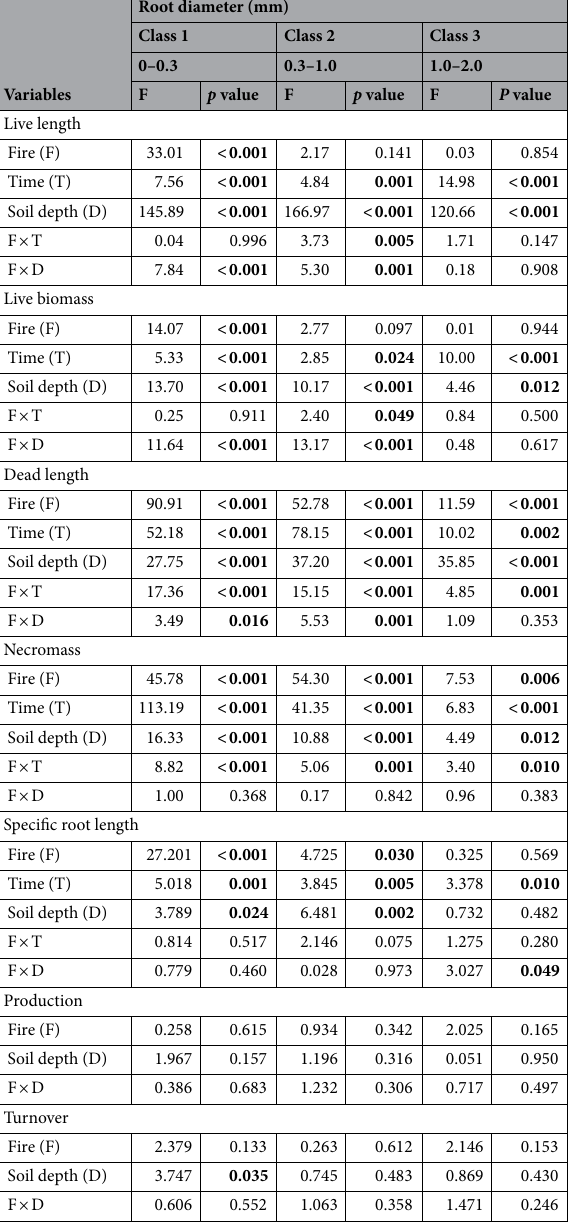
Table 2. Statistics (F and p values) from three-way ANOVAs for each fine root diameter class for the independent variables fire, sampling time (time), and soil depth, and the fire × time and fire × soil depth interactions on the dependent variables live root length, live root biomass, dead root length, necromass, and live specific root length; and statistics (F and p values) from two-way ANOVAs for each fine root diameter class for the independent variables fire and soil depth and the fire × soil depth interaction for the dependent variables annual production and turnover. Significant values are in